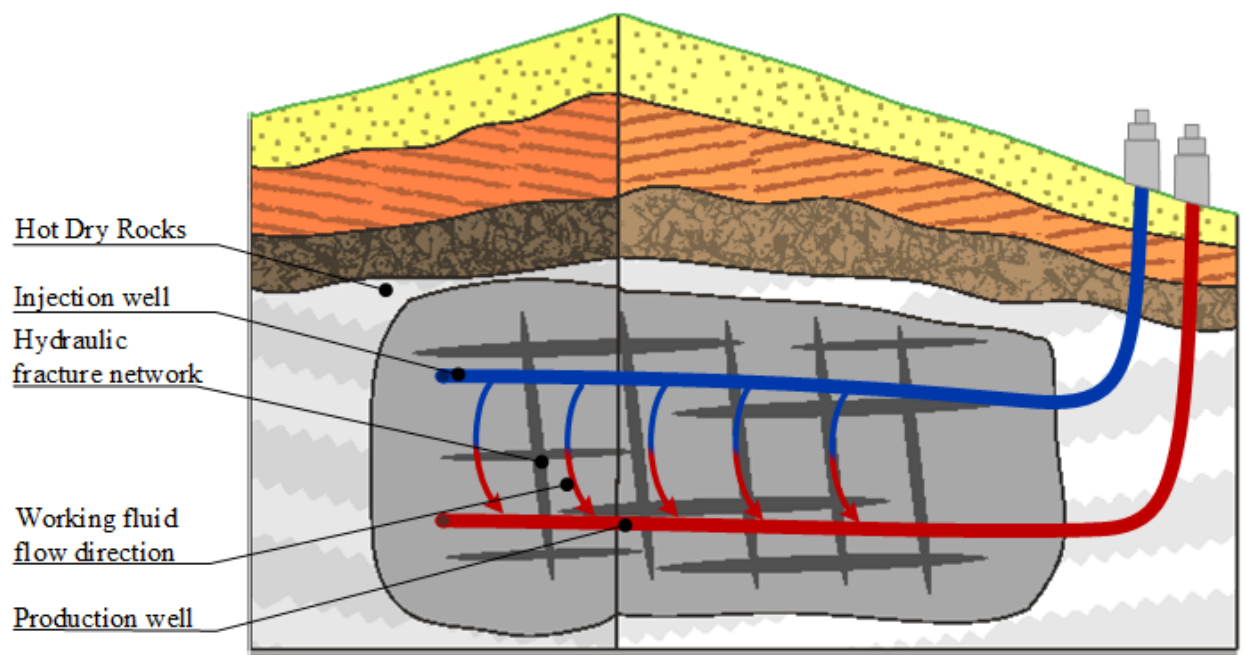
Figure 2. Proposed well setup for EGS system development with a horizontal well-doublet